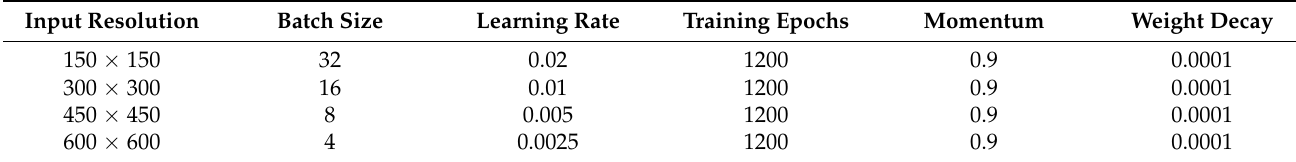
Table 1. Hyperparameter settings of network